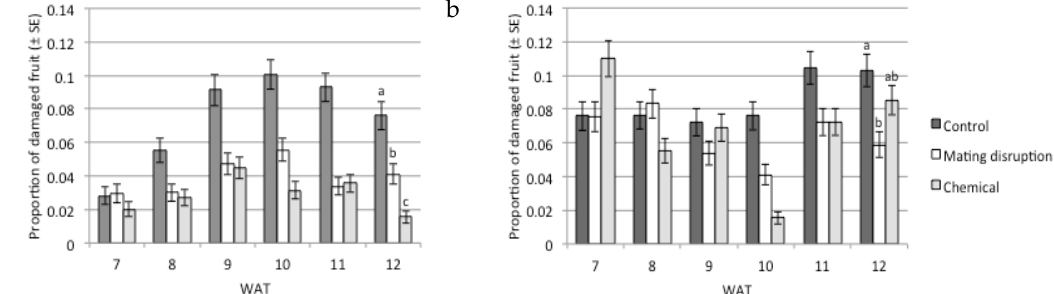
Figure 4. Proportion of damaged fruit ( ± binomial SE) for the treatments in the 2011 ( a ) and 2012 ( b ) seasons at each sampling date. WAT = weeks after transplanting. WAT 12 corresponded to the last sampling, one day before harvest. Bars bearing different letters are significantly different for p < 0.05 ( χ 2 test followed by the z-test).